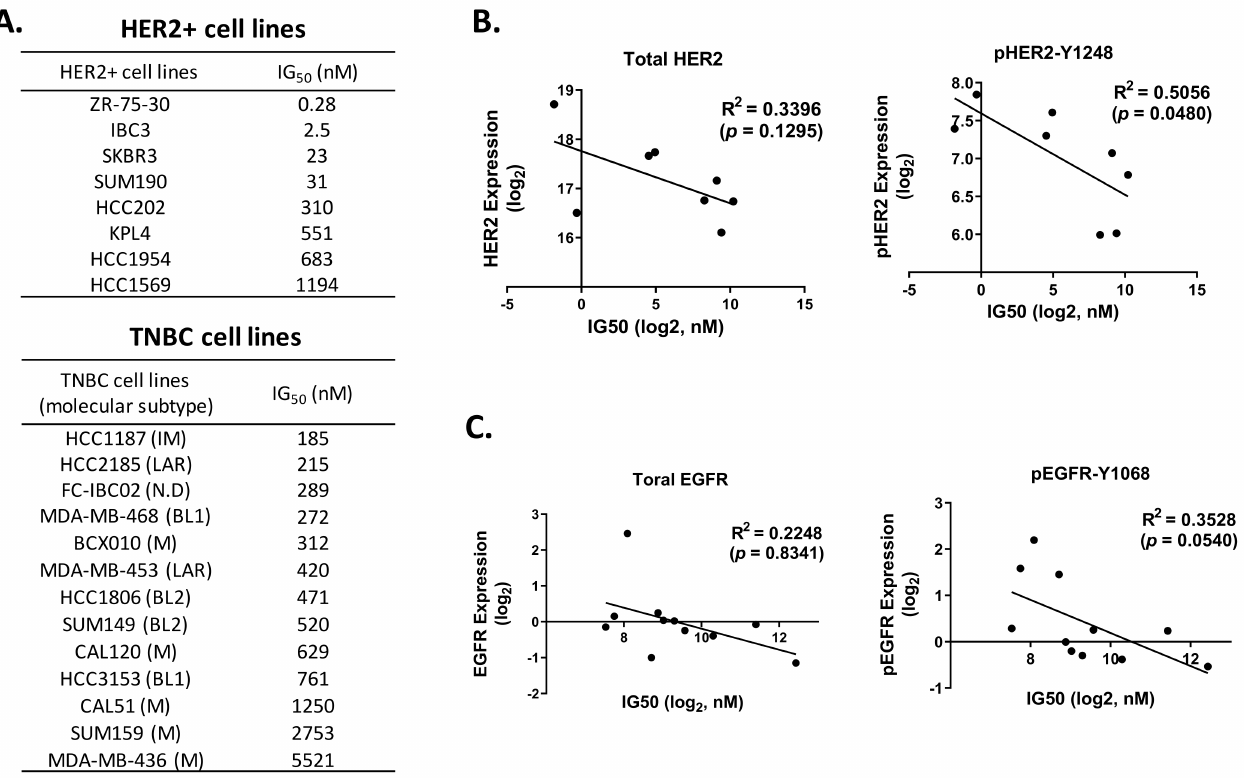
Figure 1. IG 50 and phosphorylated ERBB expression levels in HER2+ breast cancer and TNBC cell lines were correlated. ( A ). Summary of IG 50 of HER2+ breast cancer and TNBC cell lines. The anti-proliferation effect of neratinib was determined using CellTiter-Blue and sulforhodamine B staining at 5 days incubation with neratinib or DMSO control. Experiments were repeated in triplicate. BL1, basal-like 1; BL2, basal-like 2; HR; hormone receptor; IM, immunomodulatory; LAR, luminal androgen receptr; M, mesenchymal; N.D, not determined. ( B , C ). Inverse correlation between IG 50 and pHER2 expression in HER2+ breast cancer cell lines ( B ) and inverse correlation between IG 50 and pEGFR expression in TNBC cell lines ( C ). R values were calculated by Prism